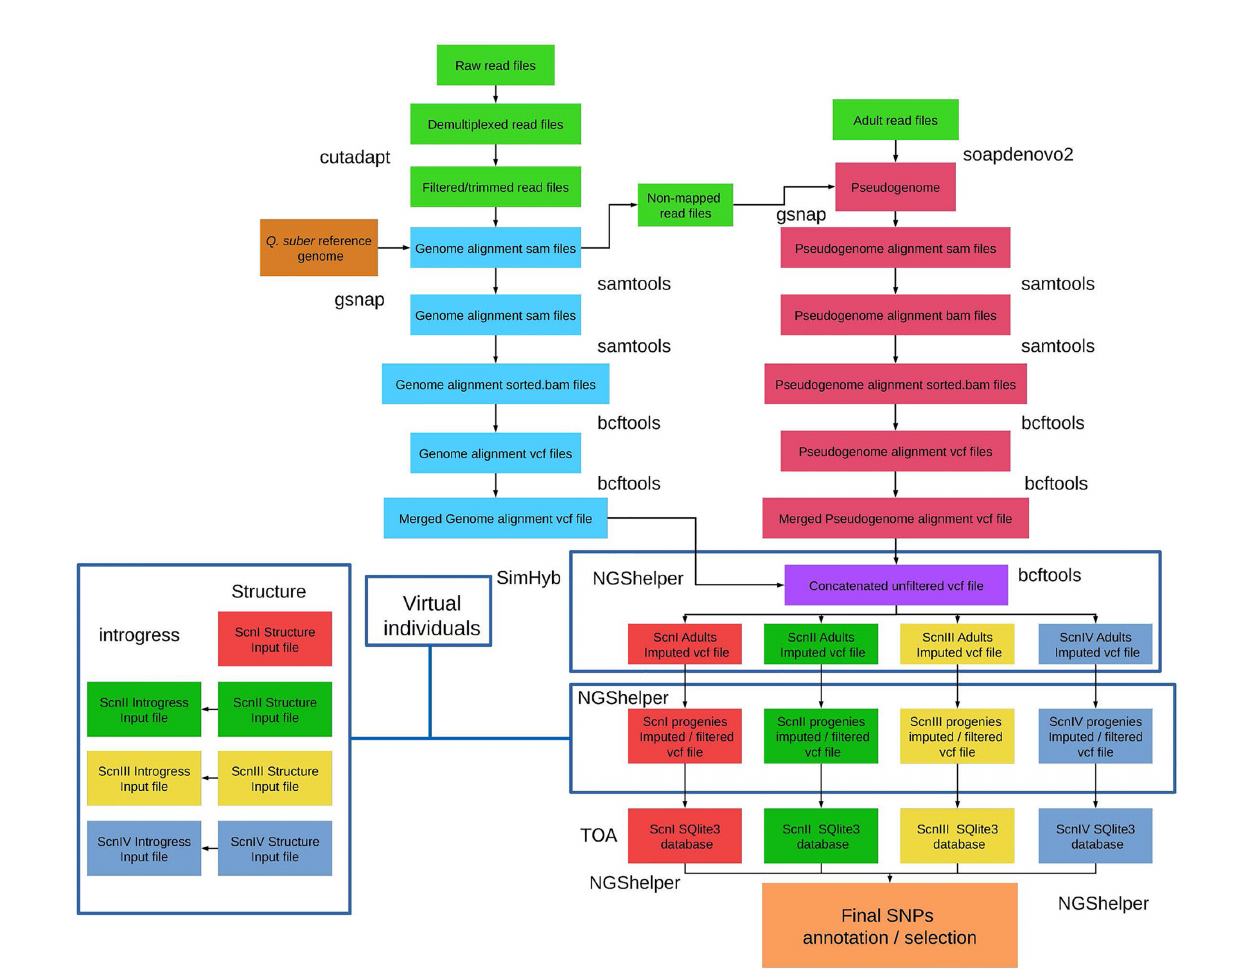
FIGURE 1 | Bioinformatics strategy for ddRADseq data analysis. BASH/R scripts and instructions to install software and dependencies are available by downloading the ddRAD-CORK-HYB package at